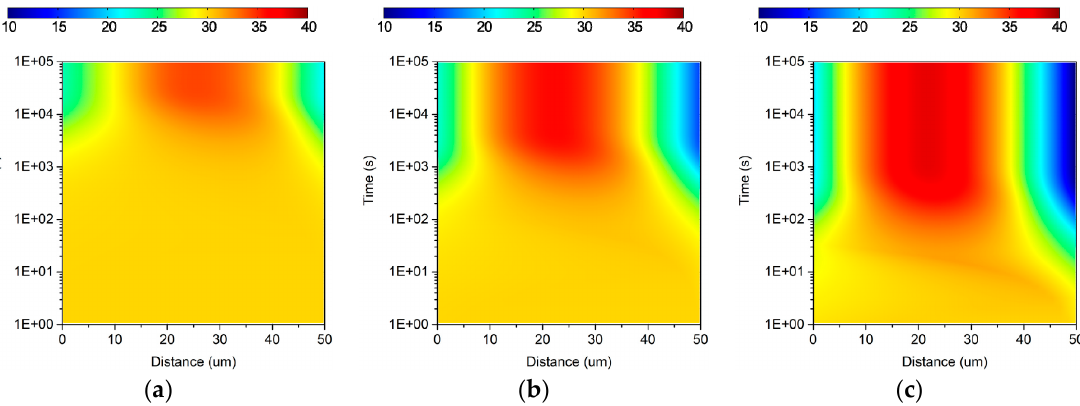
Figure 11. Time-dependent electric field distribution under DC stress only at different temperature conditions: (a) electric field (kV/mm) at room temperature (=20 °C); (b) electric field (kV/mm) at 40 °C; (c) electric field (kV/mm) at 60 °C.